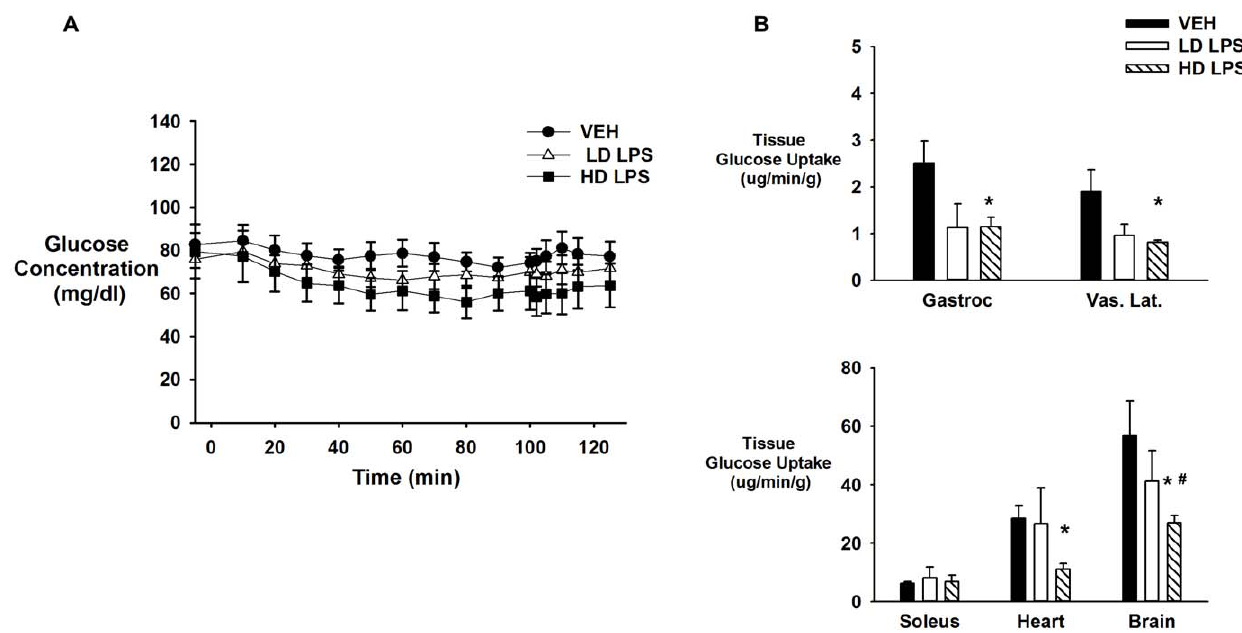
Figure 3. Basal glucose concentrations and tissue glucose uptake following vehicle and LPS treatment. Basal arterial glucose concentrations (Panel A) and tissue glucose uptake (Panel B) in chronically catheterized 5-hour fasted C57/BL6j mice that received vehicle (VEH), low- dose LPS (LD LPS; 1 m g/gBW), or high-dose LPS (HD LPS; 10 m g/gBW). Data are expressed as mean 6 SEM. * p , 0.05 vs. VEH, # p , 0.05 vs. LD LPS.